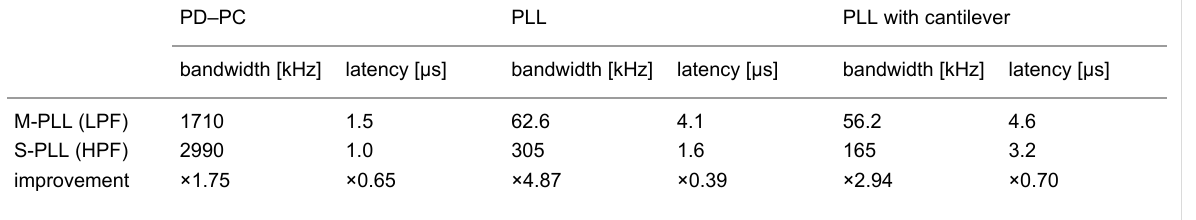
Table 2: Bandwidths and latencies of the developed PD–PC unit, PLL, and PLL with a cantilever ( f 0 = 3 MHz, USC, Nanoworld). PD–PC